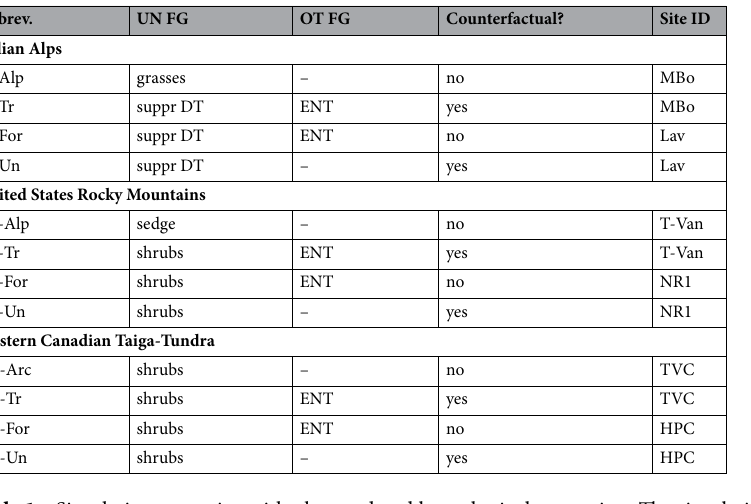
Table 1. Simulation scenarios with observed and hypothetical vegetation. The simulation abbreviations are defined as ‘location’-‘scenario’, where the locations are the Italian Alps (IT), United States Rocky Mountains (US), and the Western Canadian Taiga-Tundra (CA); and the scenarios are defined as follows: Alp—alpine meadow or fellfield, Arc—Arctic tundra, Tr—alpine/Arctic site with simulated trees, For—subalpine/sub- Arctic forest, Un—subalpine/sub-Arctic forest understory simulated without overstory trees. Throughout this paper, ‘X-’ is used to represent all locations (e.g., X-Un encompasses IT-Un, US-Un, and CA-Un). The understory (UN) and overstory (OT) functional groups (FG) for each modeled scenario are identified based on the Site IDs described in the Site Descriptions section of the “Methods”. ‘suppr DT’ refers to suppressed deciduous trees, and ‘ENT’ refers to evergreen needleleaf trees. The ‘Counterfactual’ column indicates whether synthetic vegetation was simulated.